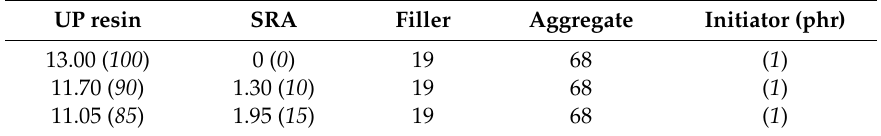
Table 7. Mix proportion for UP polymer concrete unit: wt.%.